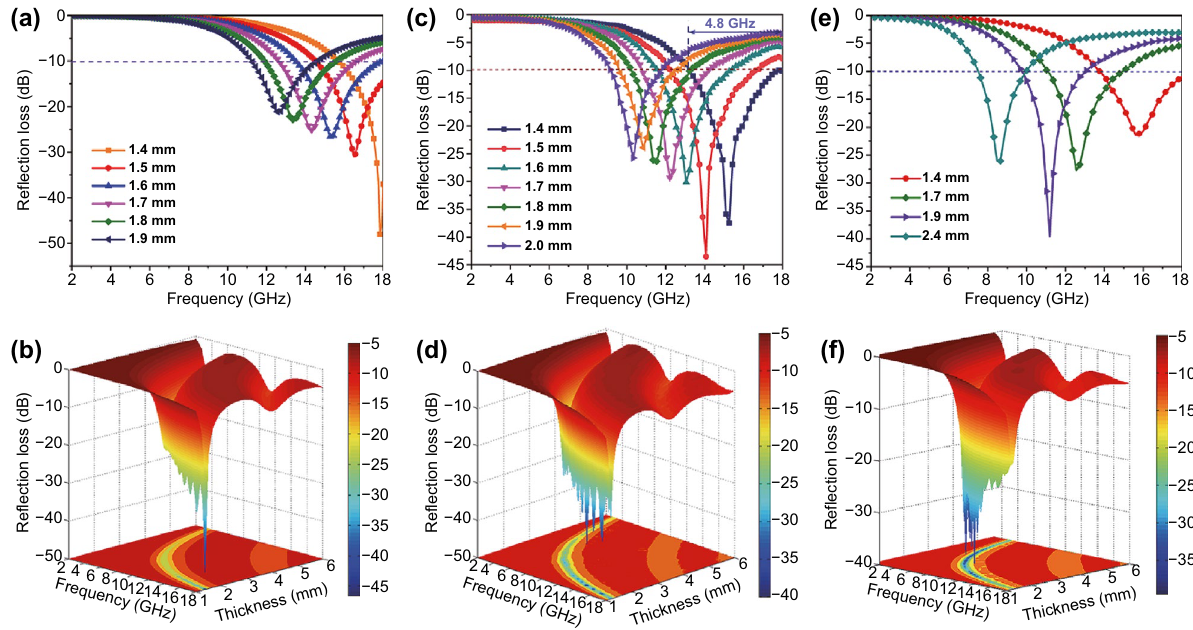
Fig. 5 RL curves and 3D presentations of VS 4 /rGO heterostructures at the thicknesses of 1 to 6 mm in the frequency range of 2–18 GHz: a, b 2VS 4 /rGO20-30%; c, d 2VS 4 /rGO40-30%; e, f 2VS 4